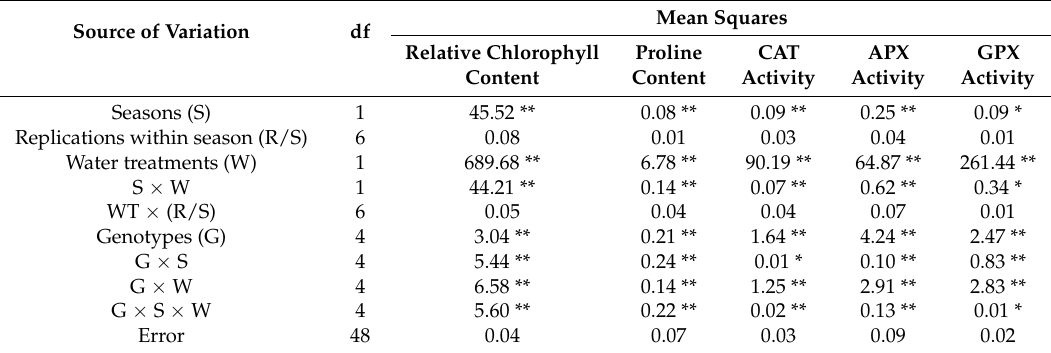
Table 5. Combined ANOVA over seasons for relative chlorophyll content, proline content, catalase (CAT), ascorbate peroxidase (APX), and guaiacol peroxidase (GPX)